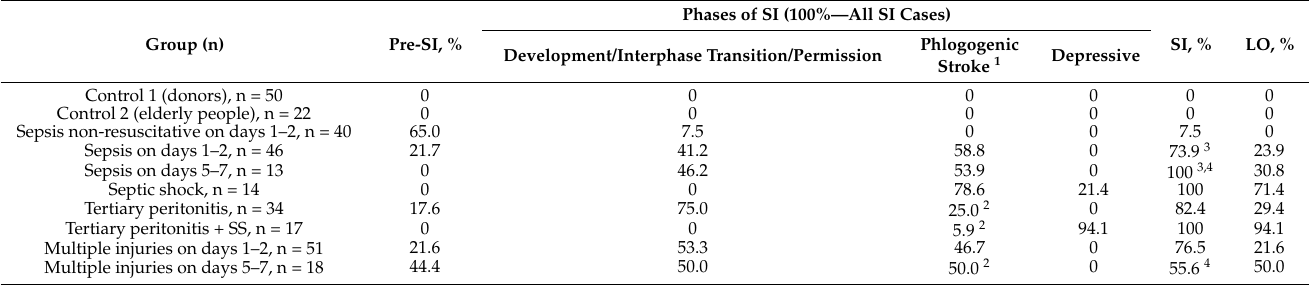
Table 6. The rate of phases of acute SI, registration of SI, and lethal outcomes in the MOD groups